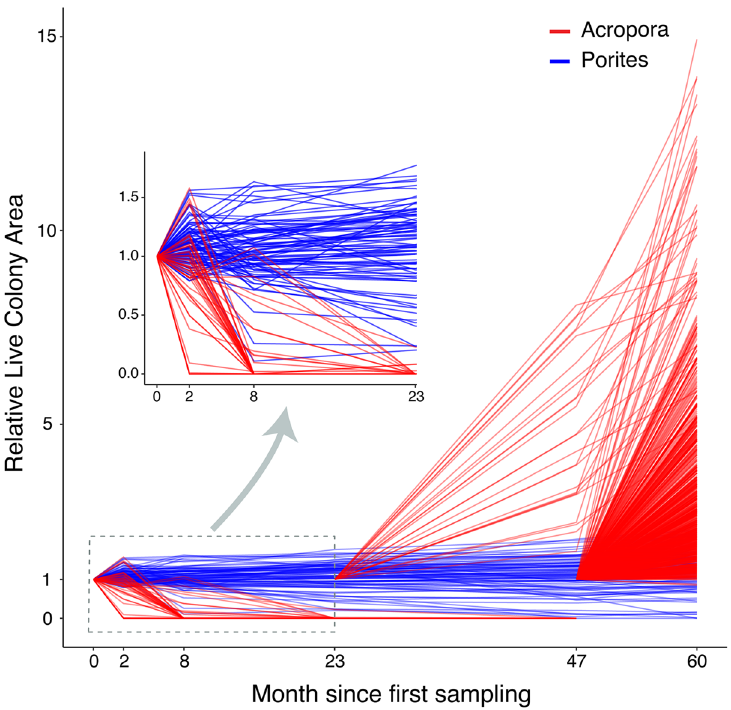
Figure 3. Relative live colony area of Acropora and massive Porites colonies over 60 months (each line represents an individual colony). Relative live colony area is the horizontal planar area of living tissue on a colony relative to the value at first detection. The small inner graph represents a zoom showing the standardized live area of Acropora and massive Porites colonies during the first 24 months since first